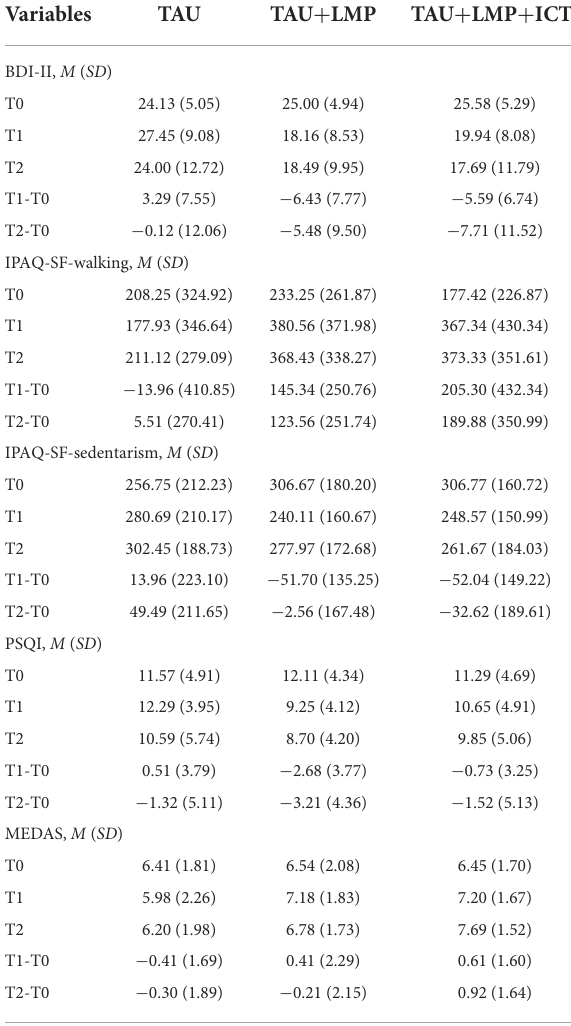
TABLE 2 Outcome variables of each group in each measurement. TABLE 3 Estimates of Fixed Effects in